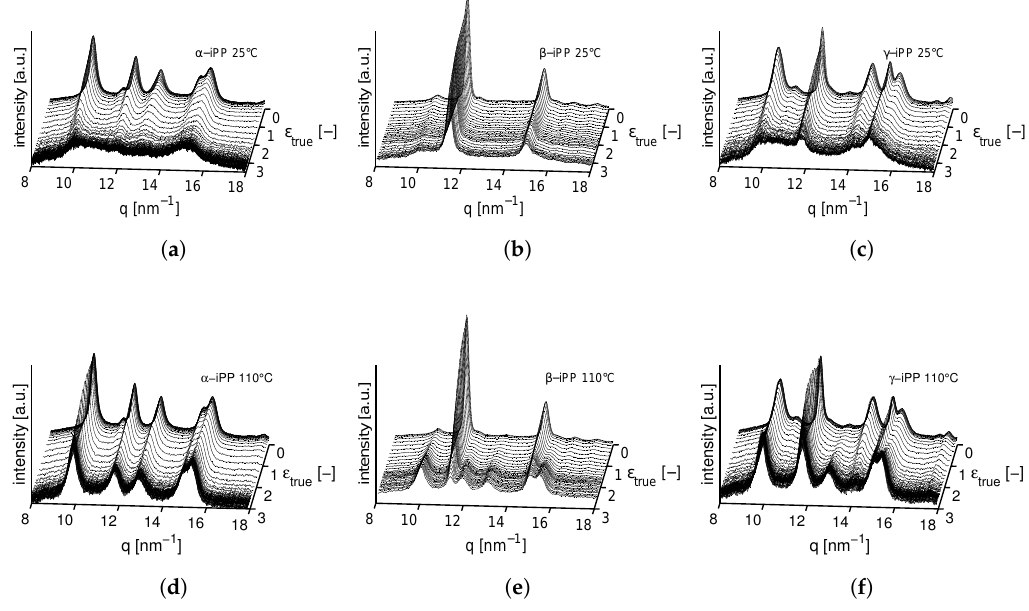
Figure 17. The integrated intensity as a function of the scattering vector q . From ( a – c ) we see the evolution of the crystallinity upon stretching at 25 ◦ C of the α -, β - and γ -iPP respectively. Similar results, obtained from stretching experiments performed at 110 ◦ C, are shown in ( d – f ). The structural evolution is given as a function of the true